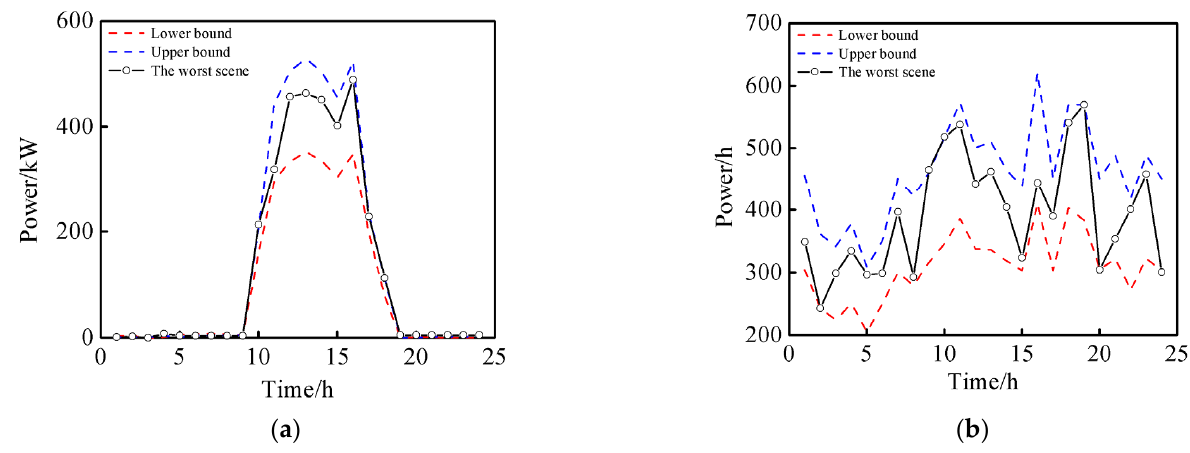
Figure 11. Worst scenario set of Subsystem 2 under Scenario 4. ( a ) Photovoltaic. ( b ) Electric load.